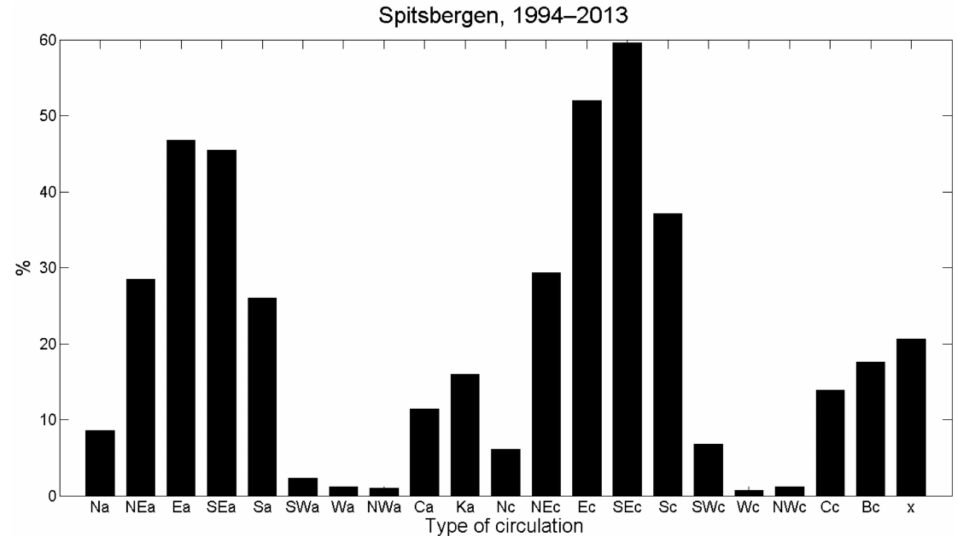
Figure 3. The conditional probability of the mesoscale land-sea breeze type circulation in each type of circulation (from Figure 2a), 1994–2013.